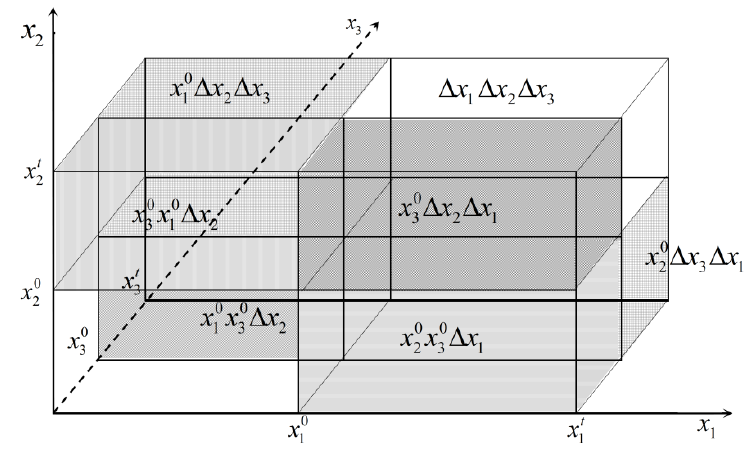
Figure 2. Index change when three factors change at different directions.